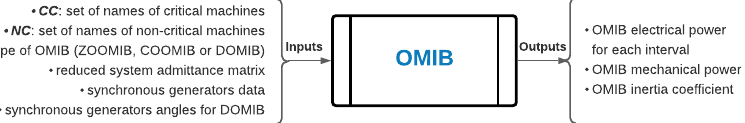
Figure 9. Schematic representation of the OMIB function to form the OMIB equivalent model based on the specified